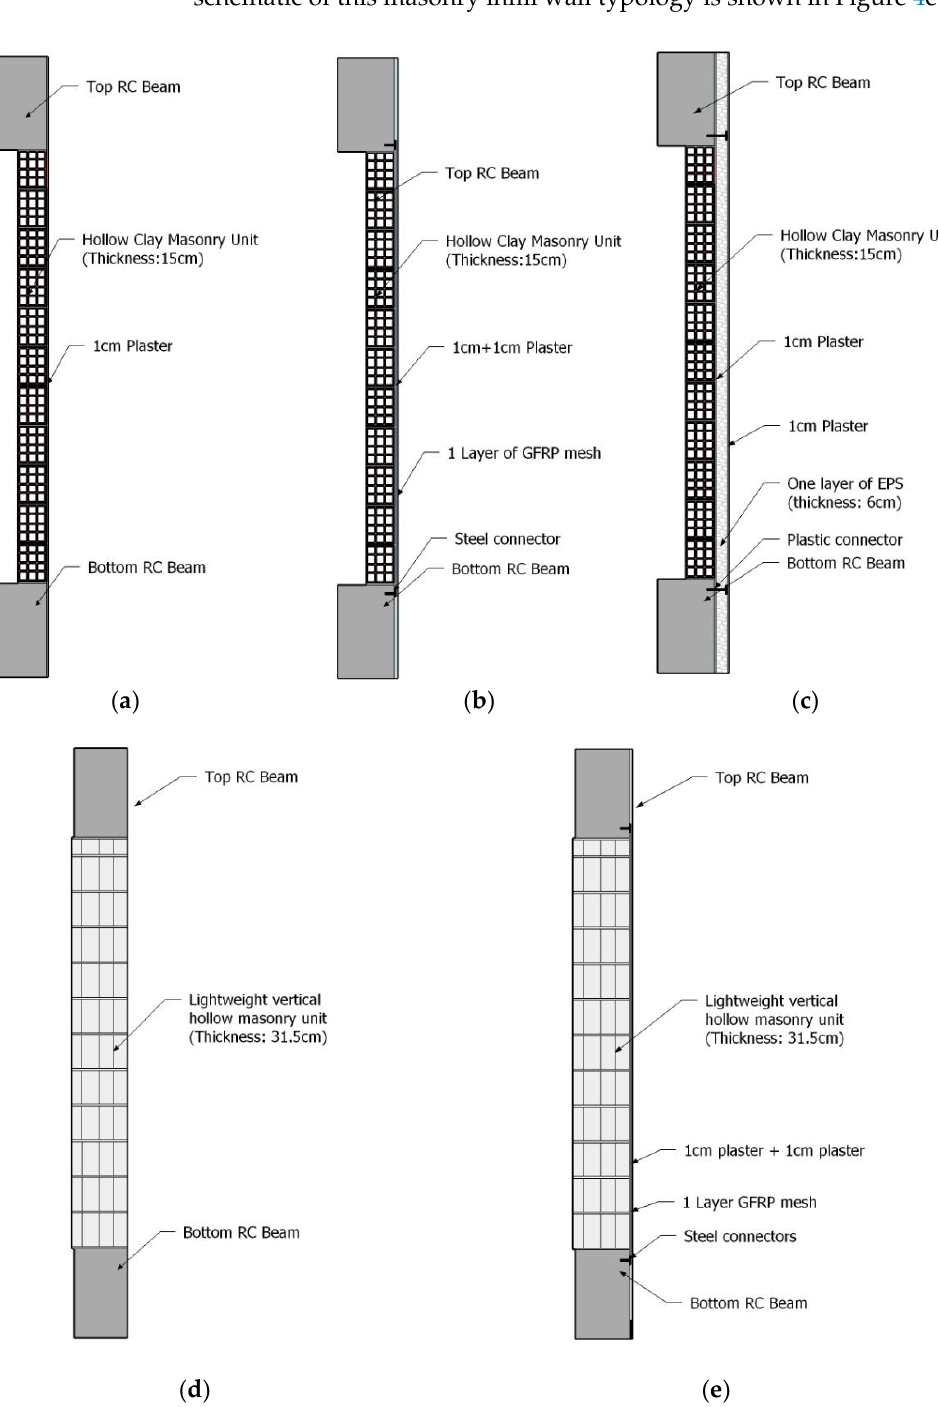
Figure 4. Types of walls under study: ( a ) type 1; ( b ) type 2; ( c ) type 3; ( d ) type 4; ( e ) type